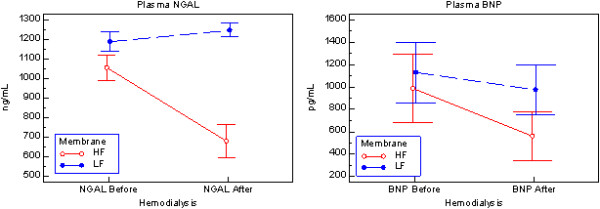
Plasma concentrations of neutrophil gelatinase-associated lipocalin and B-type natriuretic peptide before and after a dialysis session with high-flux or low-flux membranes. Plasma concentrations of neutrophil gelatinase-associated lipocalin (NGAL; left side) and B-type natriuretic peptide (BNP; right side) before and after a dialysis session with high-flux (HF; ○) membrane in 21 patients or with low-flux (LF; ●) membranes in 23 patients. Mean values ± standard error of the mean are reported.